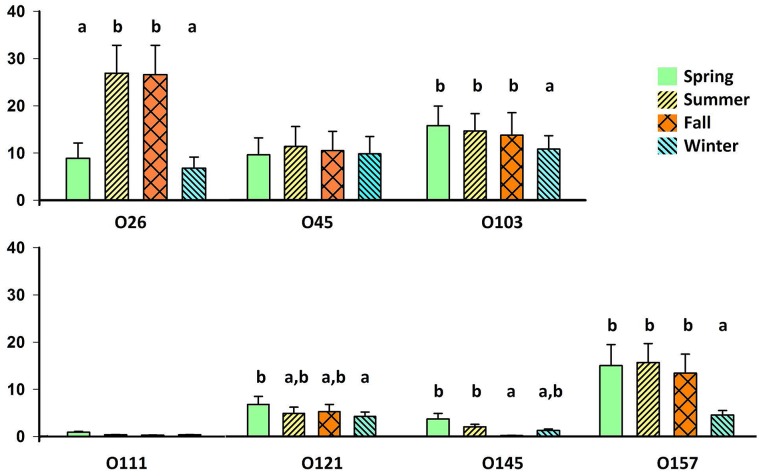
Seasonalz proportions of fecal samples yielding isolates of Top 7 serogroupsy.Bars indicate 95% confidence intervals. Means within a serogroup with different superscripts, differ (P < 0.001). zSeason: spring (March, April, May), summer (June, July, August), fall (September, October, November), winter (December, January, February). yIf 25 isolates were collected from a serogroup over a minimum of 2 samplings in a season, IMS was discontinued for subsequent samplings until the following season.